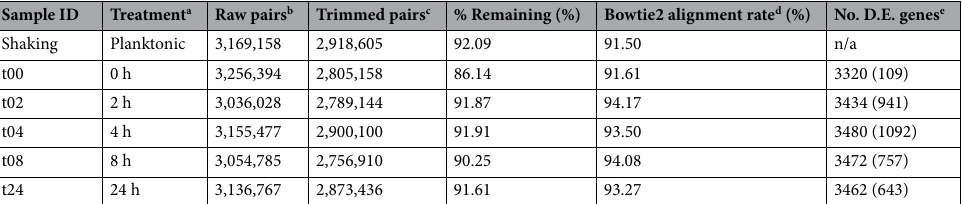
Table 1. Sample information including experimental parameters, sequencing and assembly information. a Shaking represents cells suspended and not mating; each hour following is time on filter before sampling (see methods for details). b Paired end sequencing (2 × 75) using Illumina MiSeq summed for two replicates. c Trimmed using Sickle v1.33 summed for two replicates. d Trimmed reads were aligned back to the Haloferax volcanii DS2 genome (NCBI assembly: ASM2568v1); average across two replicates. e Total number of differentially expressed genes for each time point compared to shaking control and genes with p value < 0.01 in